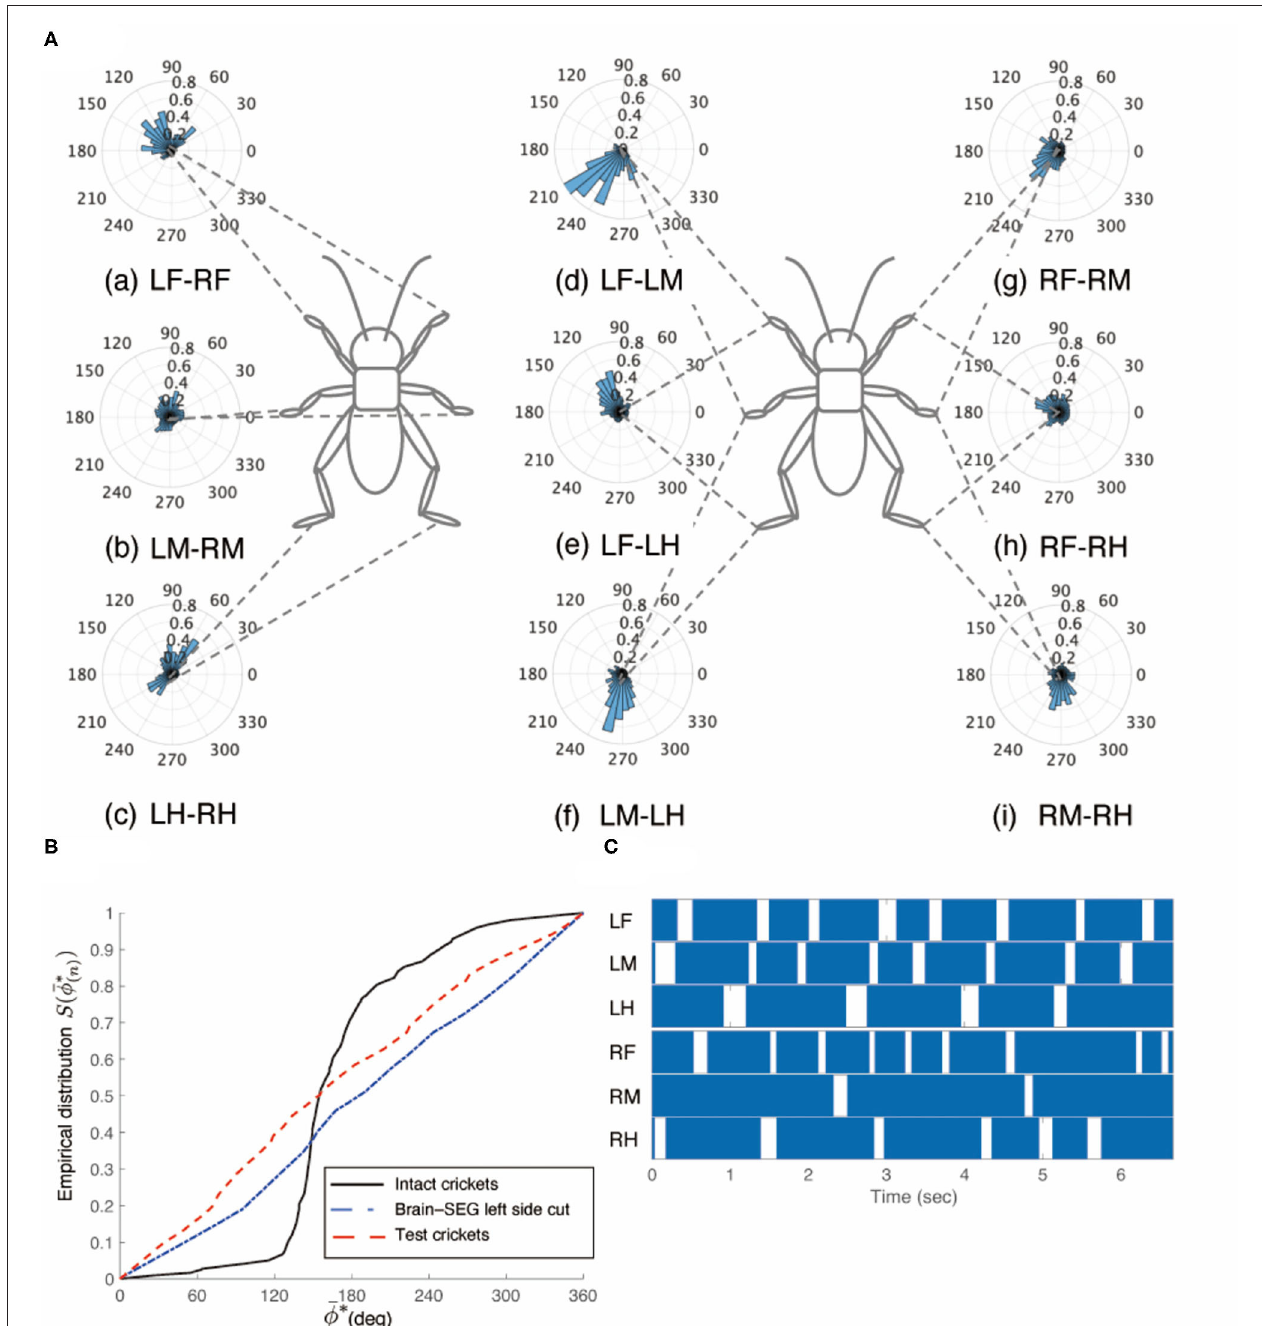
FIGURE 6 | Walking gait patterns of crickets in which left sides of nerve connectives between brain and SEG, and between SEG and prothoracic ganglion were cut. (A) Polar histograms indicate phase differences between two legs in test crickets ( N = 5). The test crickets continued to turn clockwise. The polar histograms demonstrate that the walking pattern was not a tripod gait. (a–i) Phase differences between pairs of legs. (B) Comparison of the empirical distribution function of phase differences between left and right legs Φ LM − RM . The black line indicates the empirical distribution function of the intact crickets; the blue line indicates that of the test crickets, and the red line indicates that of the crickets in which the left side of the nerve connectives between the brain and SEG was cut (shown in Figure 3B ). (C) Gait chart diagram of test cricket. The filled parts indicate the duration of the power stroke period, and the blank part indicates the duration of the recovery stroke. This demonstrates that the walking pattern was not a tripod in the test crickets. LF, left foreleg; RF, right foreleg; LM, left midleg; RM, right midleg; LH, left hind leg; RH, right hind leg.